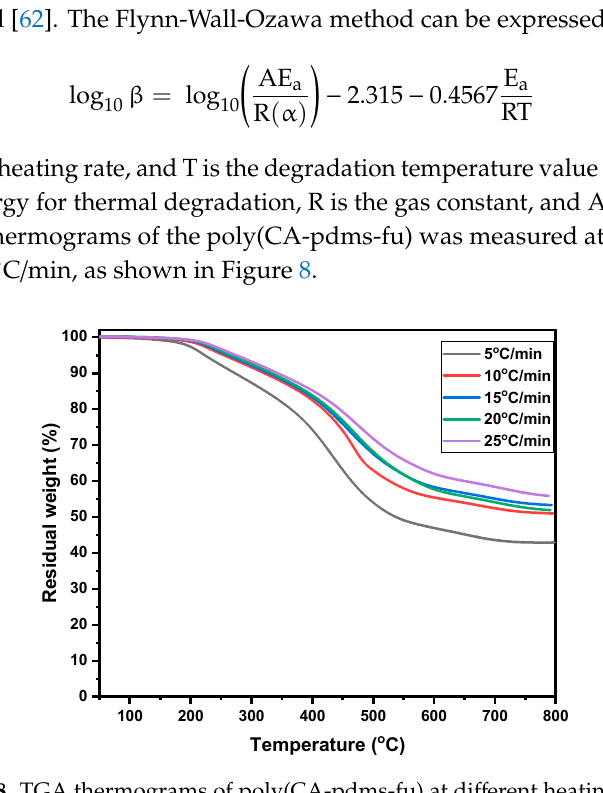
Figure 8. TGA thermograms of poly(CA-pdms-fu) at different heating rates.